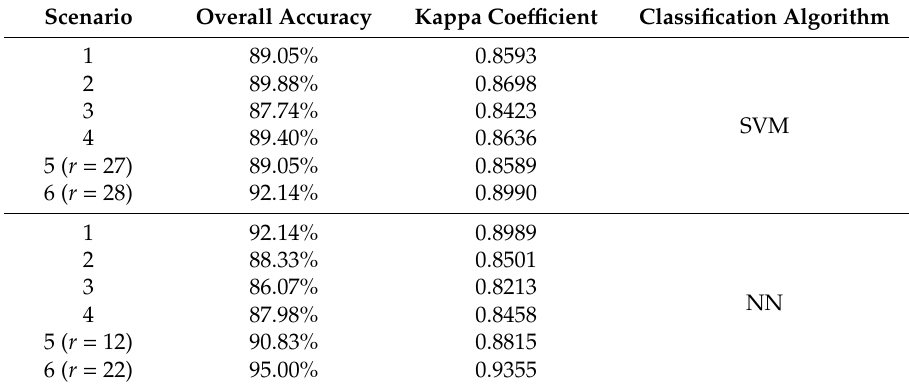
Table 5. Overall accuracy and Kappa coe ffi cient with support vector machine (SVM) and neural network (NN) algorithms for di ff erent